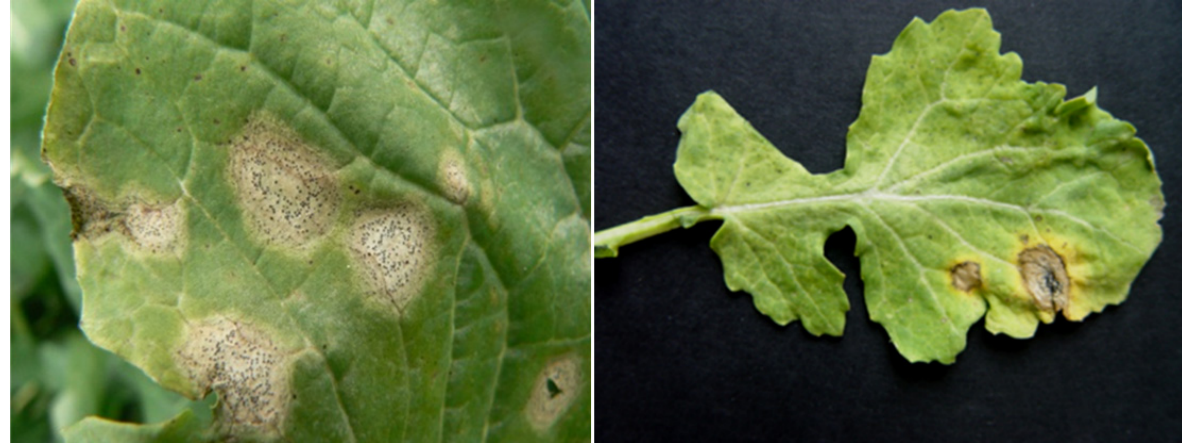
Figure 4. Examples of leaf damage on hybrid genotypes caused by L. maculans .